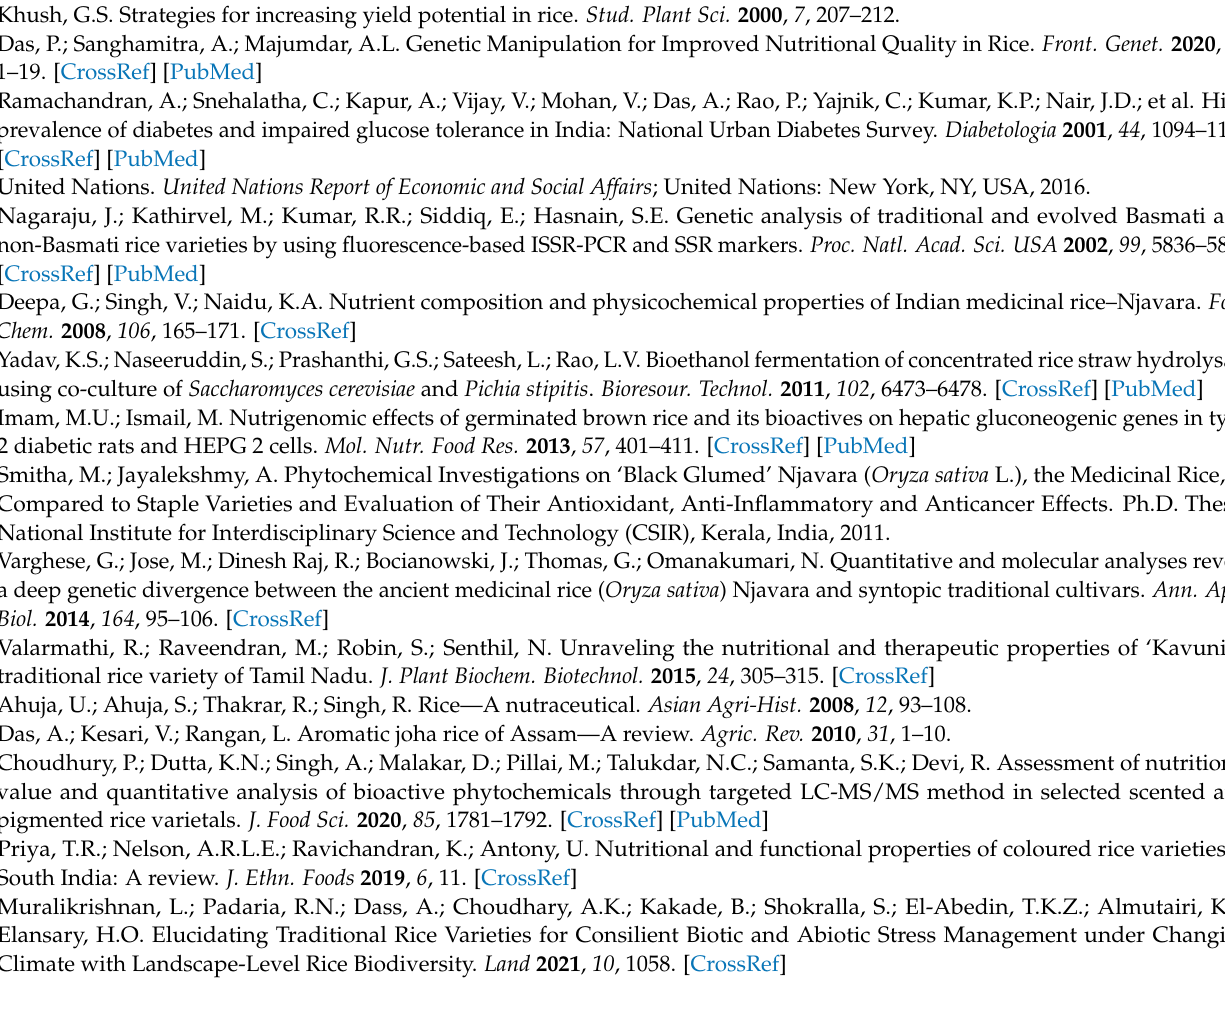
Figure S2: Heat map analysis of 113 metabolites in Mappillai Samba and CBMAS 14065; Table S1: List of metabolites identified in Mappillai Samba and CBMAS 14065; Table S2: The abundance